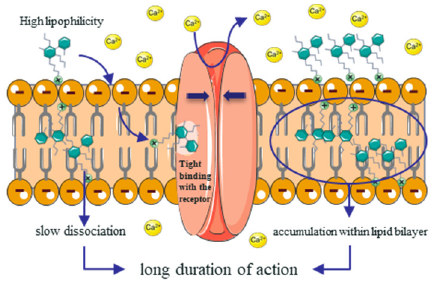
Figure 6. Diagram of the interaction of amlodipine with the dihydropyridine receptors, and the cumulative effect.